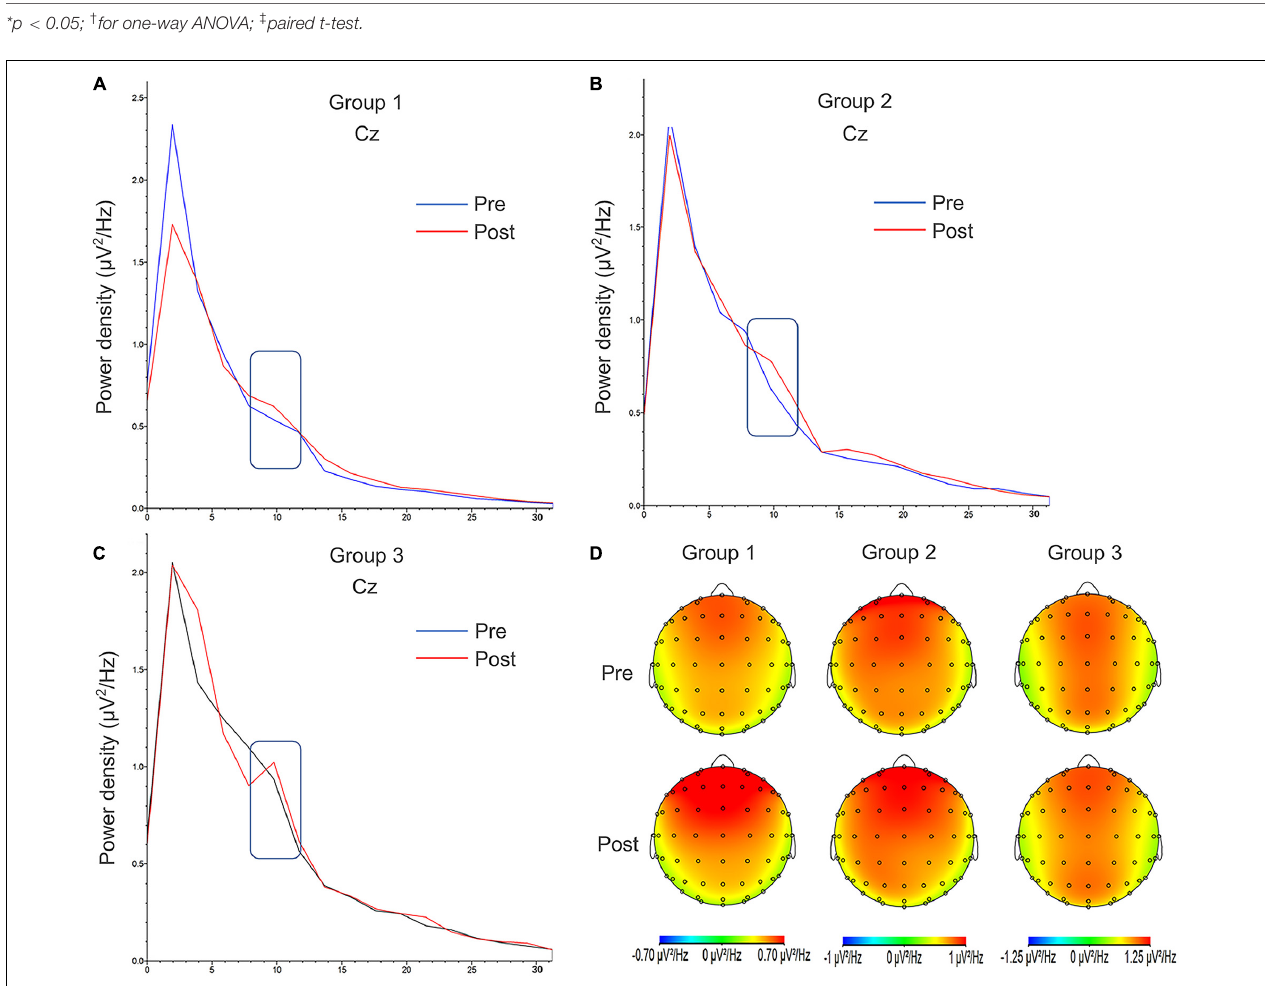
FIGURE 7 | Power density distribution and alpha band topographic maps of the three groups before contact heat pain stimulation. (A) Group 1. (B) Group 2. (C) Group 3. (D) The topographic maps of alpha band oscillation power density before and after intervention. The alpha band (8–12Hz) is marked with a rectangular border. The alpha oscillation power density is largest in the frontal region. Pre, pretest; Post, posttest.